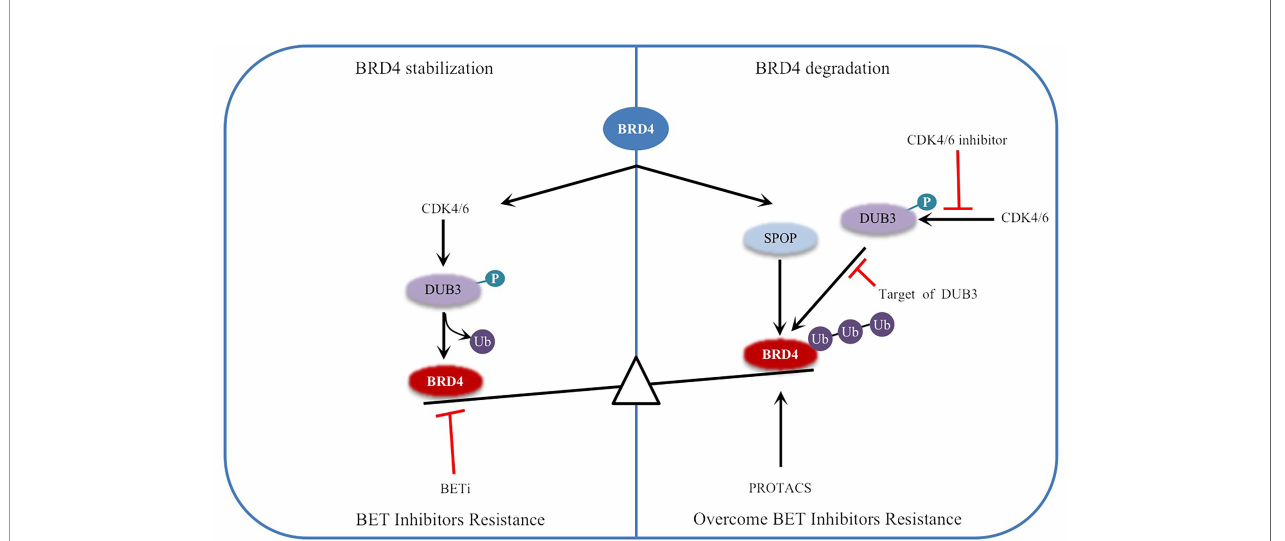
FIGURE 2 | Regulation of BRD4 stability by ubiquitination and deubiquitination: The stability of BRD4 is mediated by SPOP and DUB3. CDK4/6 phosphorylates and activates DUB3, leading to the imbalance between ubiquitination and deubiquitination, and stabilizes BRD4 by antagonizing SPOP mediated ubiquitination, resulting in BETi resistance. Inhibitors of CDK4/6 or targeted inhibition of DUB3 will lead to ubiquitination degradation of BRD4 and overcome BETi resistance. Therefore, PROTACs targeting BRD4 degradation have been developed. Black arrows indicate positive effects. Red perpendicular bars indicate negative effects. Ub , ubiquitin; P,